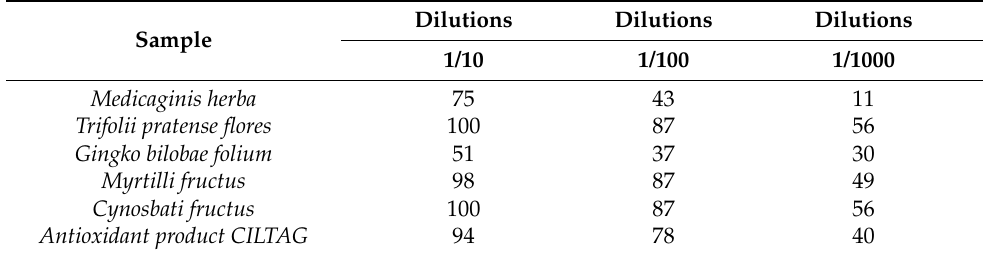
Table 8. Percentage inhibition (%) of lipid